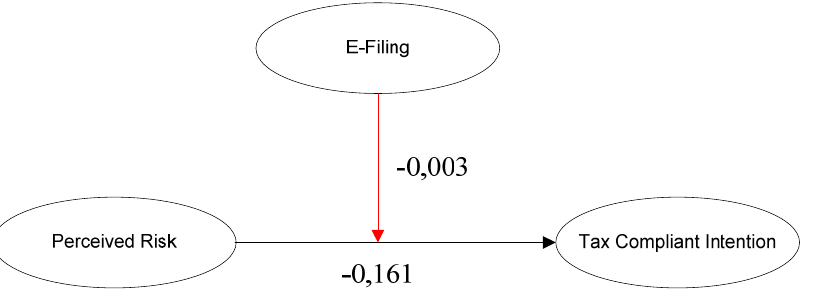
Figure 2. Moderation Effect of e ‐ Filing on the Relationship between Religiosity on Tax Compliant Intention. Source: Research Data (2020).